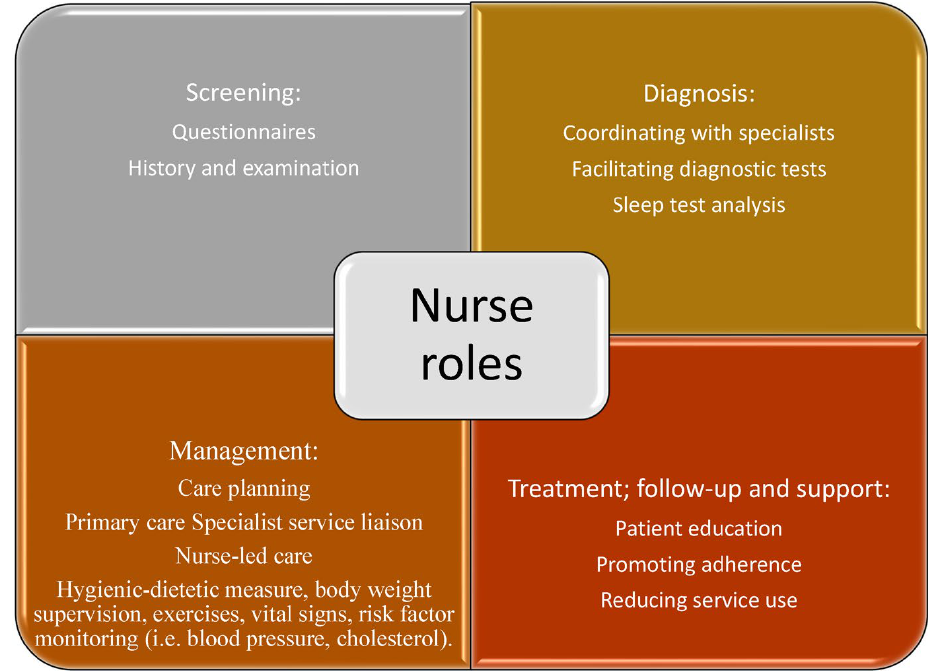
Figure 2. Conceptualisation of nurse roles in care of patients with OSA.